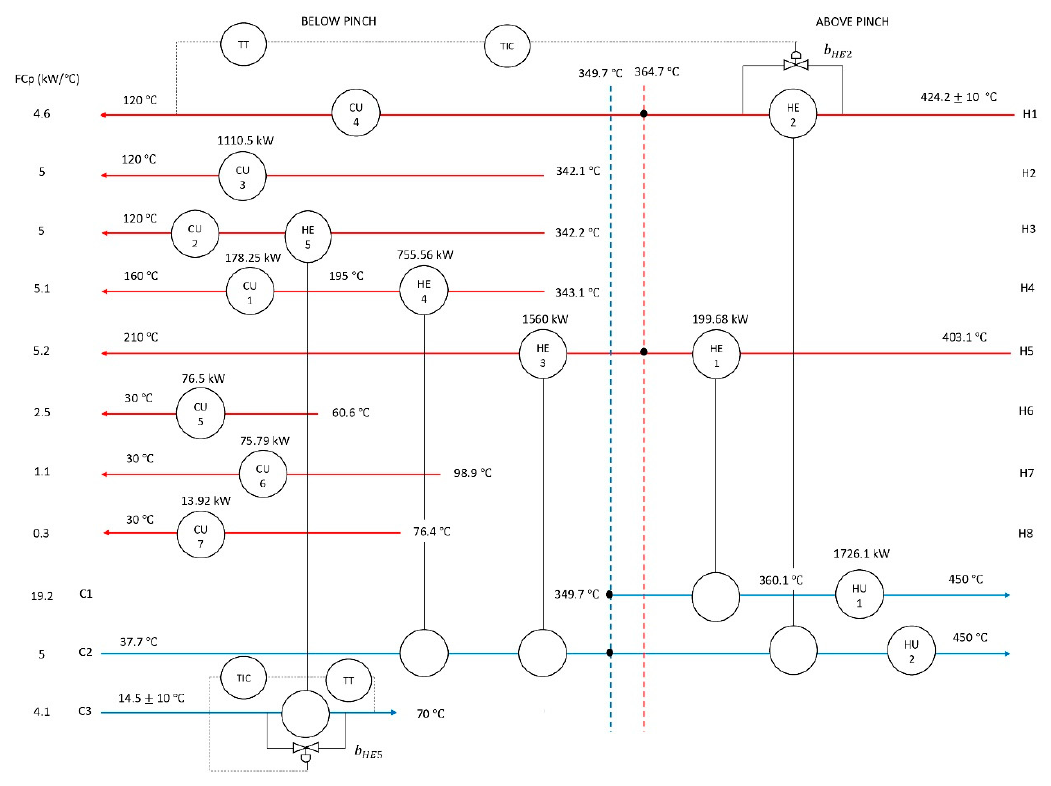
Figure 18. Overall HEN with bypass placement for Case Study 1.